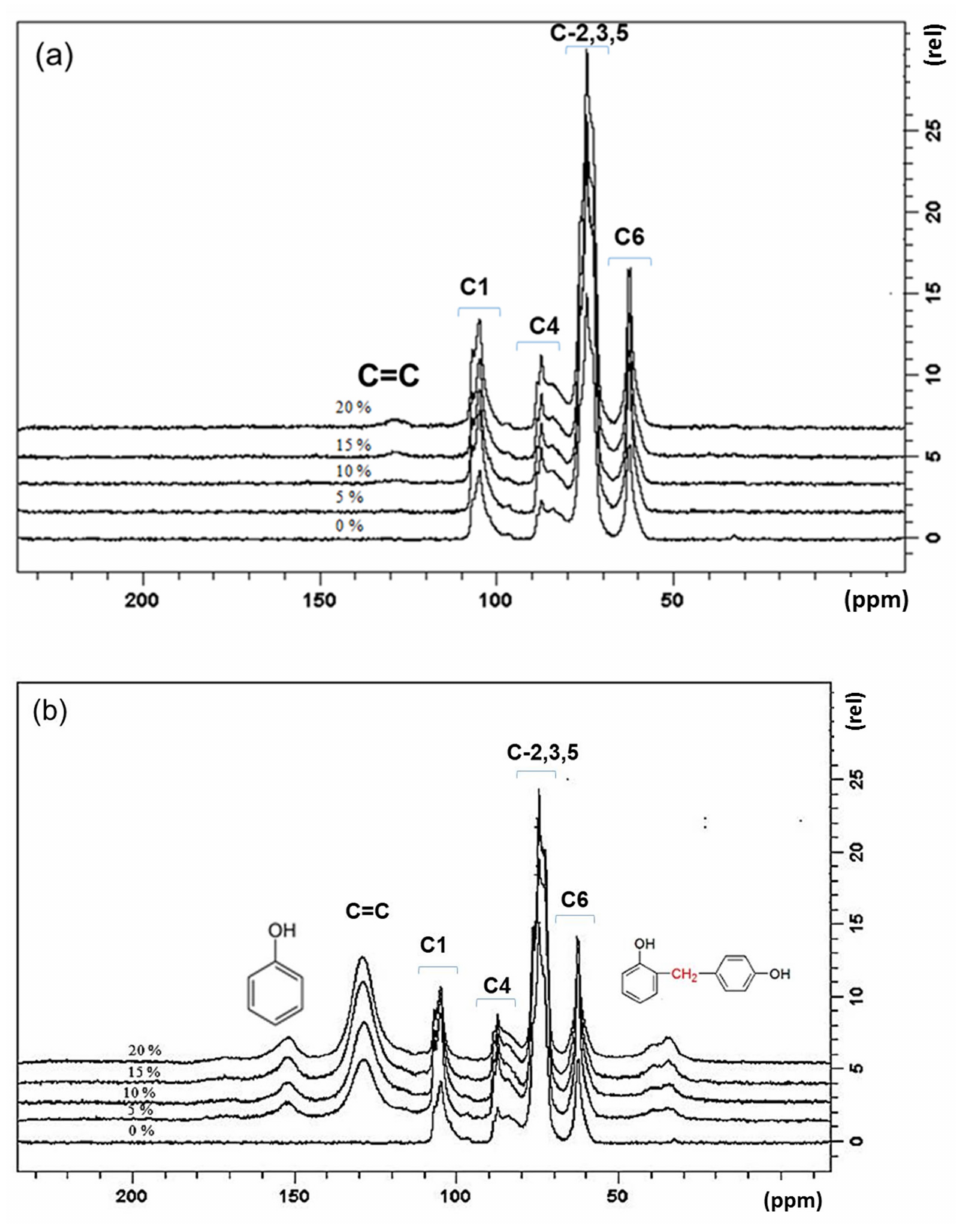
Figure 4. Cross polarization magic-angle-spinning nuclear magnetic resonance (CP-MAS NMR) of ( a ) PCMD and ( b ) PCMW